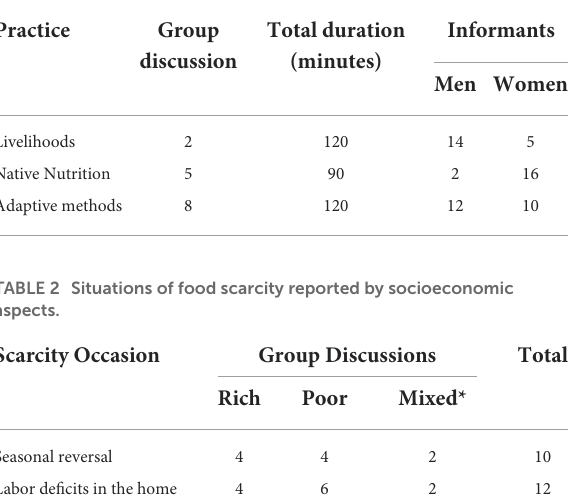
TABLE 1 Quantity of discussion groups and sources per topic.